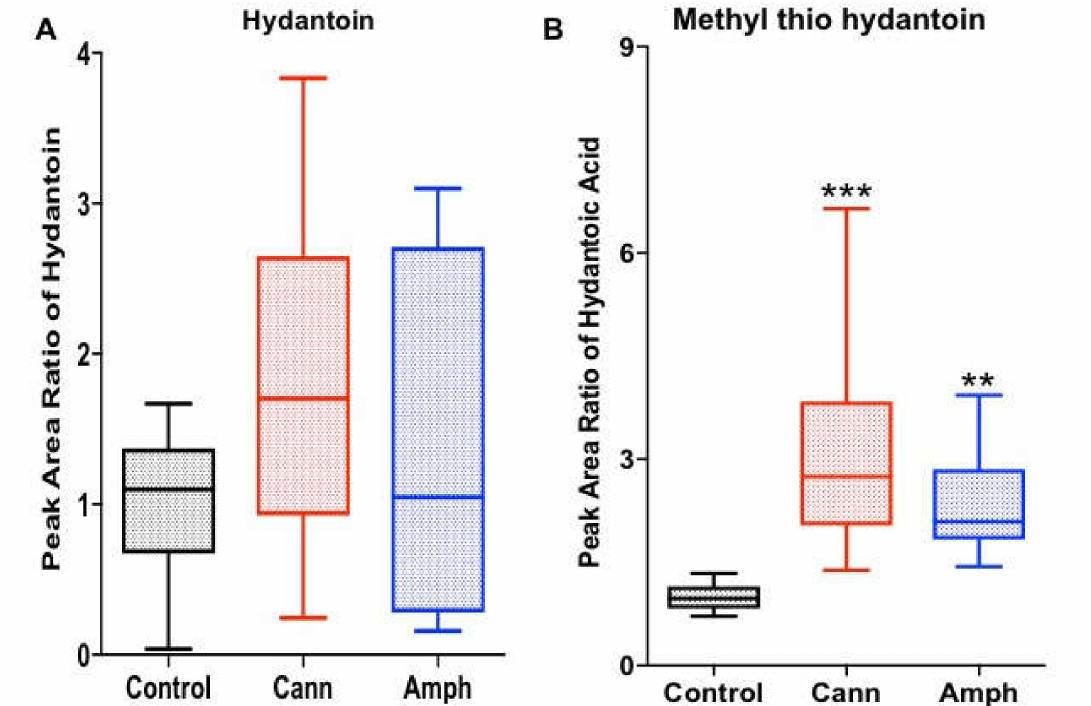
Figure 5. Effects of cannabis or amphetamine on hydantoin and methyl thio hydantoin in cannabis or amphetamine use disorder patients. ( A ) Kruskal–Wallis test followed by Dunn’s post hoc analysis did not show any differences in hydantoin among the groups. ( B ) Kruskal–Wallis test followed by Dunn’s post hoc analysis showed that methyl thio hydantoin was higher in both amphetamine and cannabis groups compared with the control group. (** p < 0.01, *** p < 0.001). Cann, cannabis. Amph,